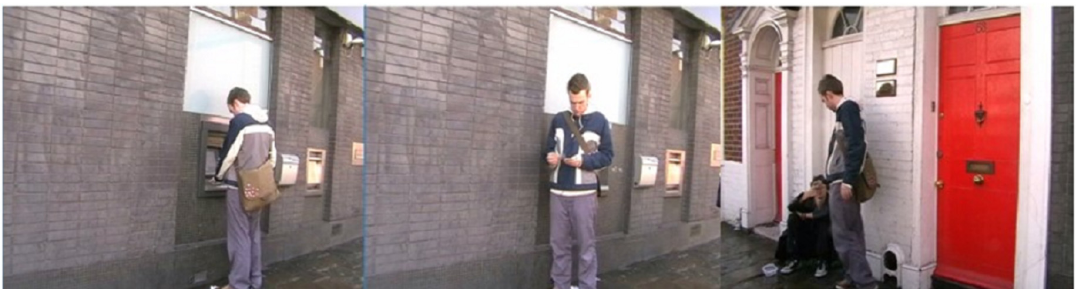
Figure 5. Screenshots of male actor in the high-cost altruism condition.